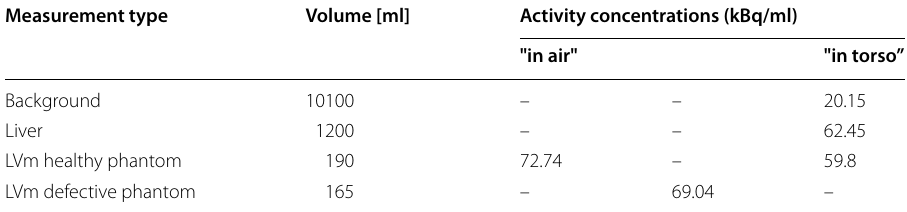
Table 1 Decay corrected activity concentrations in kBq/ml applied for phantom preparations Measurement type